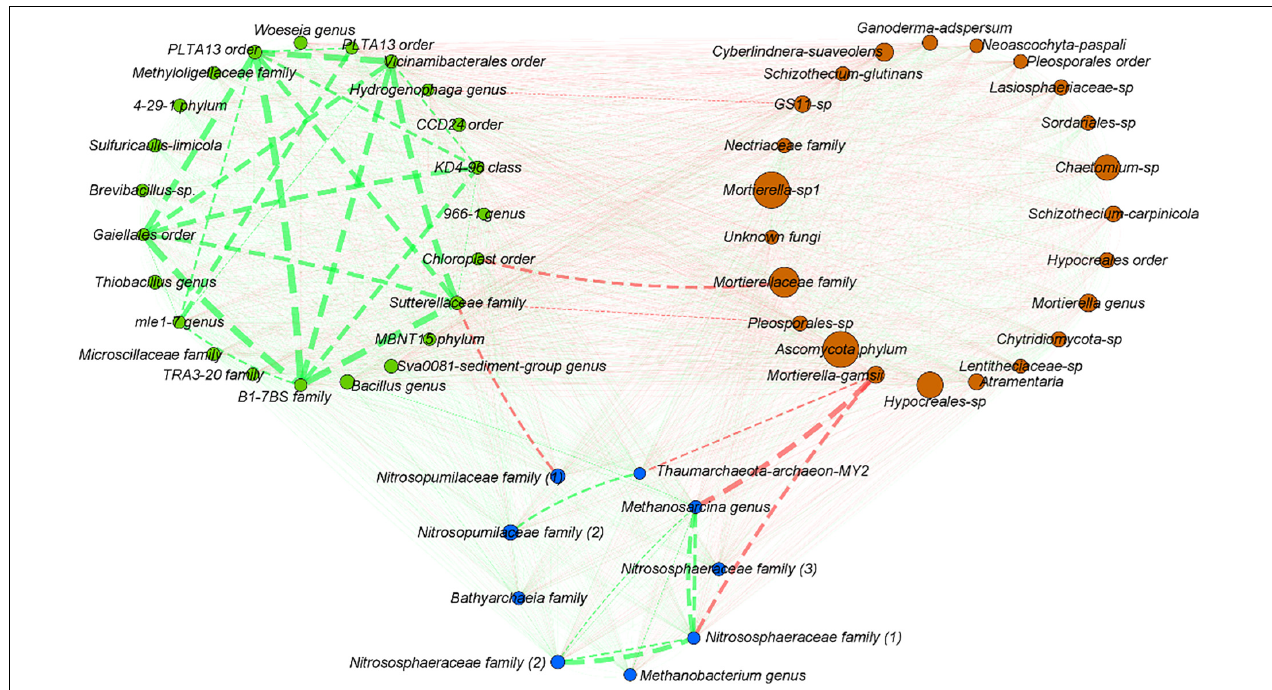
FIGURE 7 | Co-occurrence network between the 23 most abundant bacterial OTUs, the 9 most abundant archaeal OTUs, and the 23 most abundant fungal OTUs. Network was built using Pearson, Spearman, and Bray–Curtis analyses, both for significance thresholds < 0.05. Co-occurrences (co-presence marked in green, mutual exclusion marked in red) are highlighted if significant for at least two of the three previously cited methods. The line width is proportional to the weight of the correlation, ranged from –0.828 to –0.710 for mutual exclusion (red) and from 0.881 to 0.981 for co-presence (green). The number of OTUs represented was chosen arbitrarily after many assays to make the network more readable as